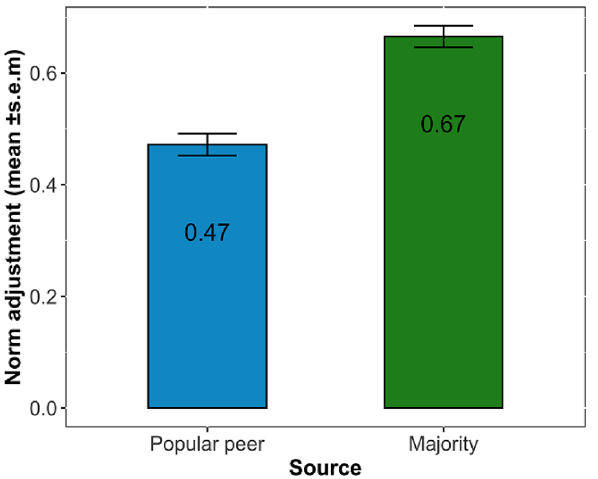
Figure 2. Peer norms impact adolescents’ personal norms. Bars show participants’ norm adjustments from wave 1 to wave 2 that were averaged across trials, broken down by social source. Error bars indicate ± s.e.m